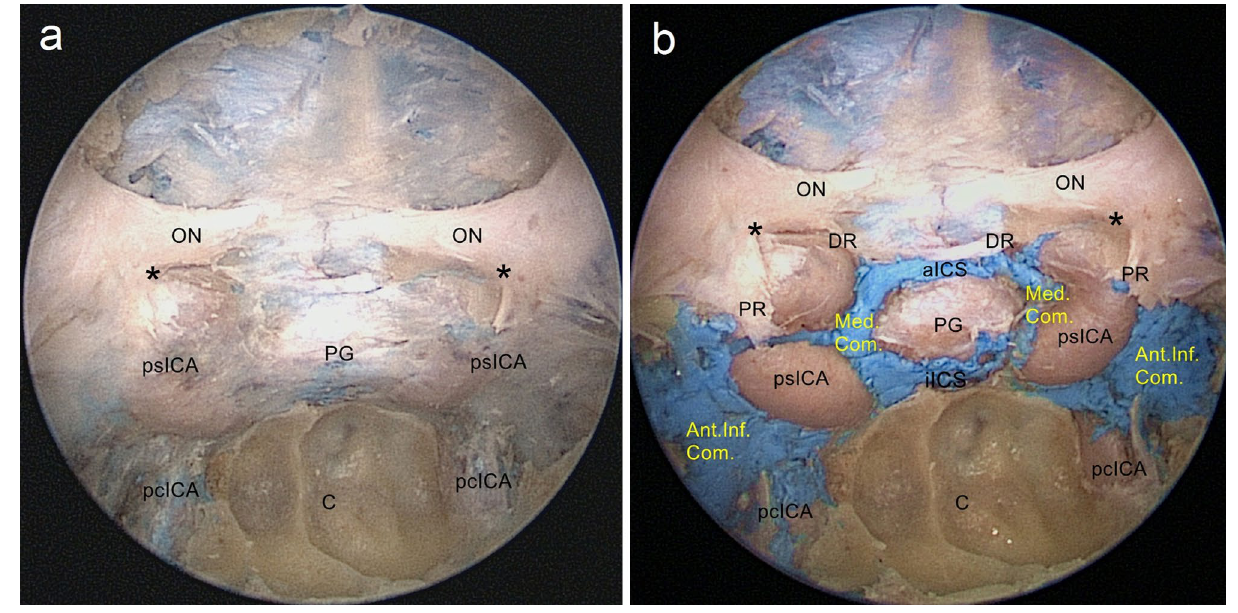
Figure 3. Endoscopic endonasal view of the ICAs, CSs and ICSs. ( a ) After the bone overlying the sphenoidal sinus and sellar floor is removed, the dural layer is shown. ( b ) The layer and latex covering the anterior portion of the pituitary gland and the medial wall of the CS, are resected to expose the CS compartments. ICSs are venous interconnections between the bilateral CSs. C clivus, ON optic nerve, psICA parasellar segment of the ICA, pcICA paraclival segment of the ICA, PG pituitary gland, DR distal ring, PR proximal ring, aICS anterior intercavernous sinus, iICS inferior intercavernous sinus, Med.Com. medial compartment of the CS, Ant.Inf.Com. anteroinferior compartment of the CS. *Opticocarotid recess.